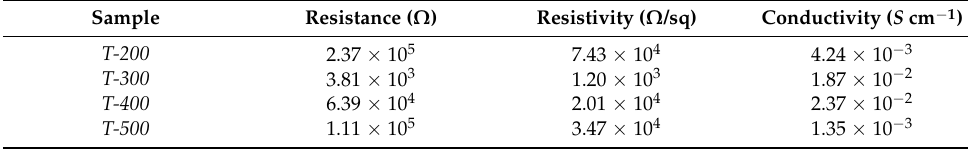
Table 1. In-depth electrical characteristics of the fabricated MMO